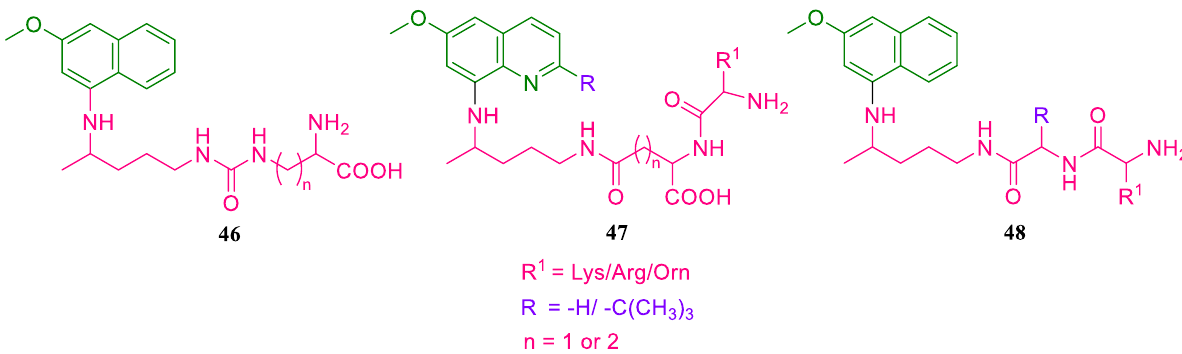
Figure 44. 8-aminoquinolines conjugated amino acids/dipeptides/pseudopeptides analogues.